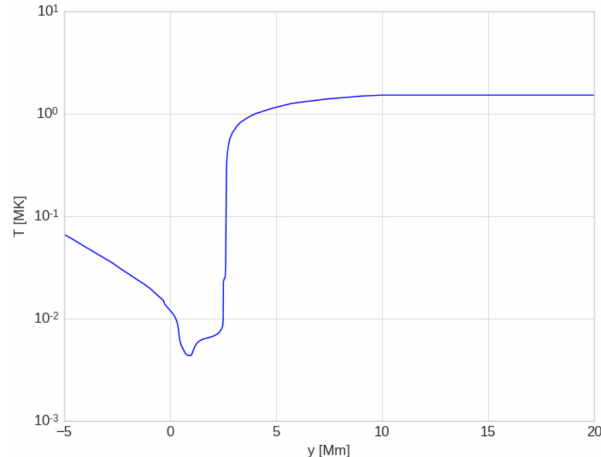
Figure 2. Temperature variation with height in the initial static solar